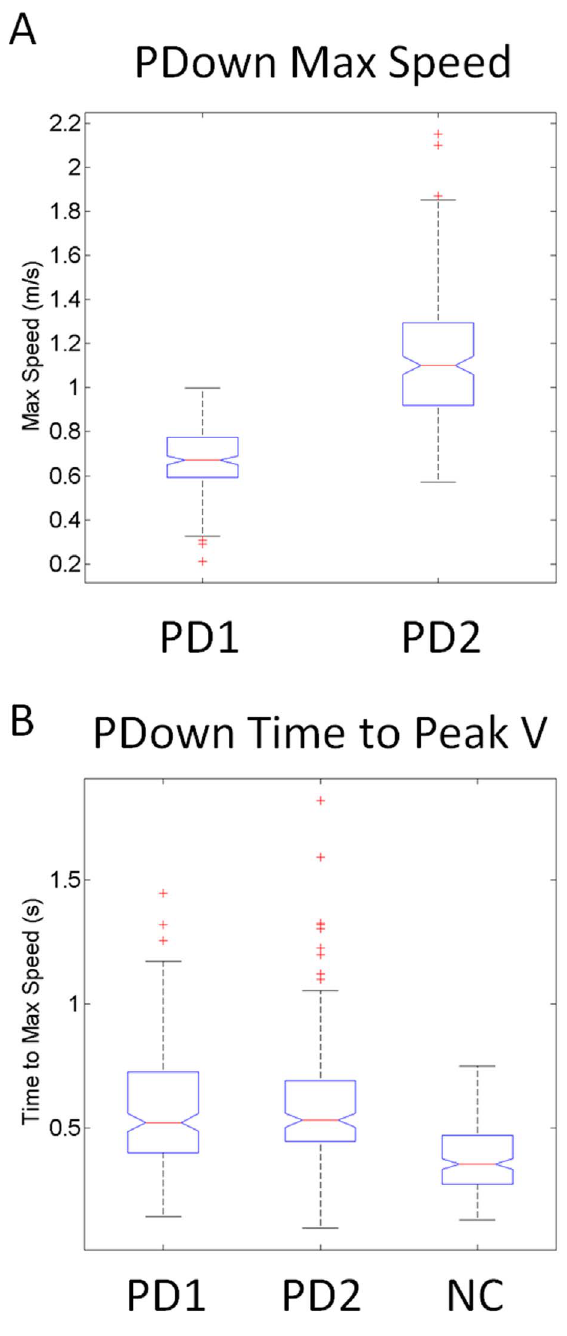
Figure 9. Effects of increasing task difficulty on the speed and timing of the reach by priming the final desired orientation such as to evoke complex mental rotation of the stimulus. (A) PD1 patients moved significantly slower than PD2 patients (median 0.65 m/s vs. 1.15 m/s, x 2 215.05, p , 10 2 48 ) according to the values of the hand’s maximum speed returning from the target to the resting position. (B) The timing of the maximum speed was not significantly different in the two patient groups (median 0.52 s, x 2 2.86, p . 0.1) but both groups took longer to reach the velocity peak than NC’s did (median 0.35 s, x 2 123.5, p , 10 2 27